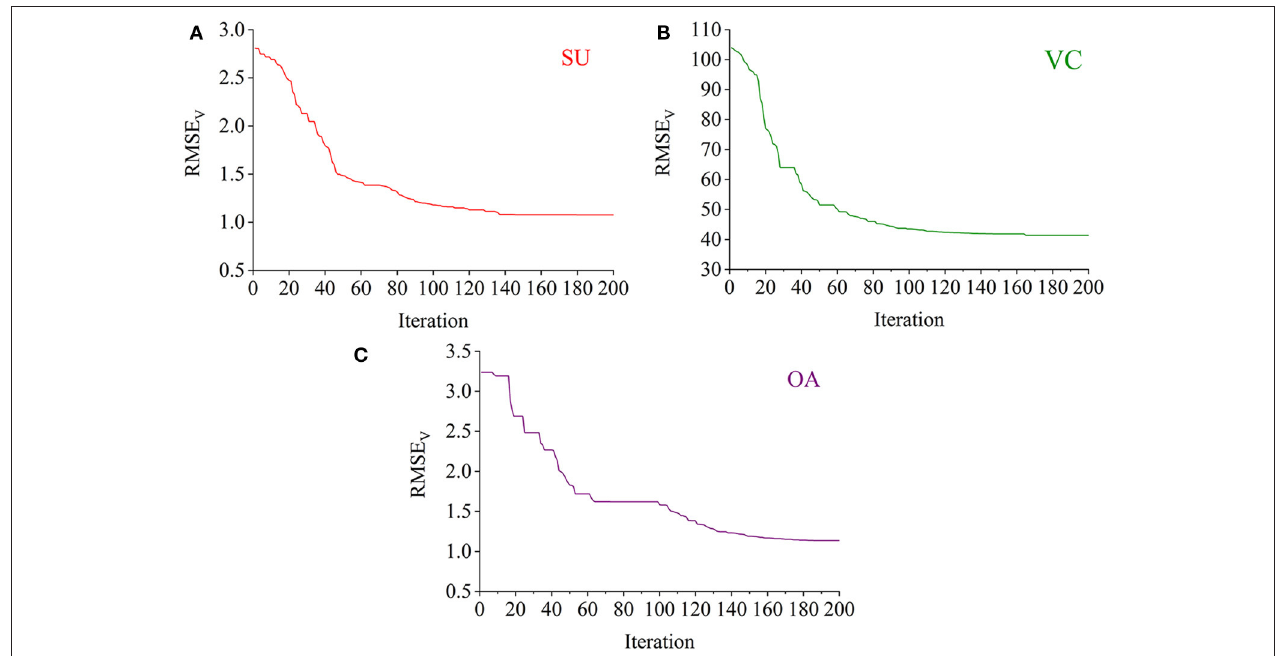
FIGURE 5 | The iterative optimization of the RBF-PLS models for the NIRHI data training ( A–C are for the prediction of SU, VC, and OA, respectively).